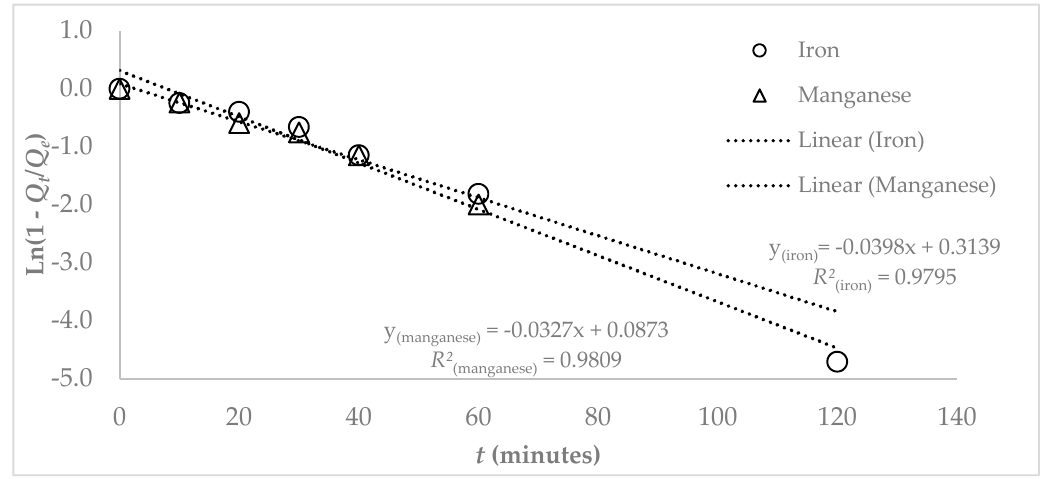
Figure 12. Intra-particle diffusion t 1/2 -dependence of iron and manganese adsorption capacity on to zeolite Y. Dashed lines indicate the linear fitting at intra-particle diffusion and equilibrium state regions. Initial Fe = 1.15 mg L − 1 ; Initial Mn = 1.61 mg L − 1 ; adsorbent dose = 2 g L − 1 , T = 25 °C; water pH = 6.5.